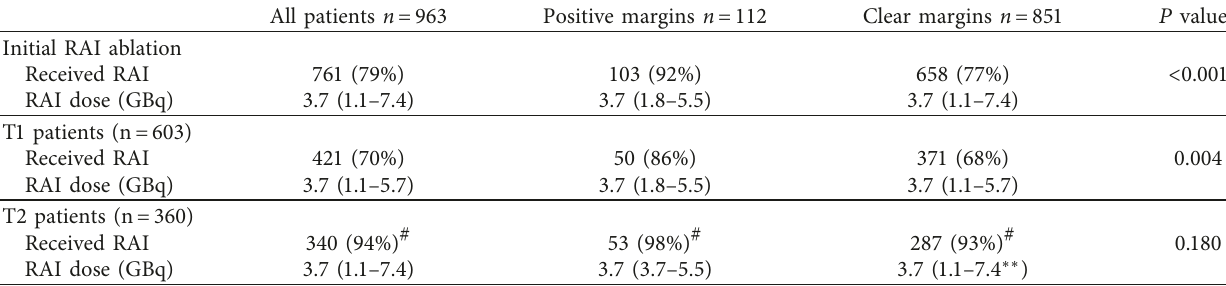
Table 3: RAI treatment: positive versus clear margins.